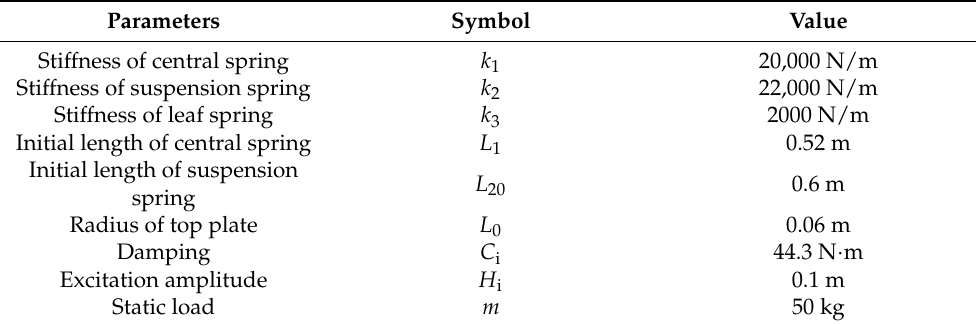
Table 1. The physical parameters for building the experimental